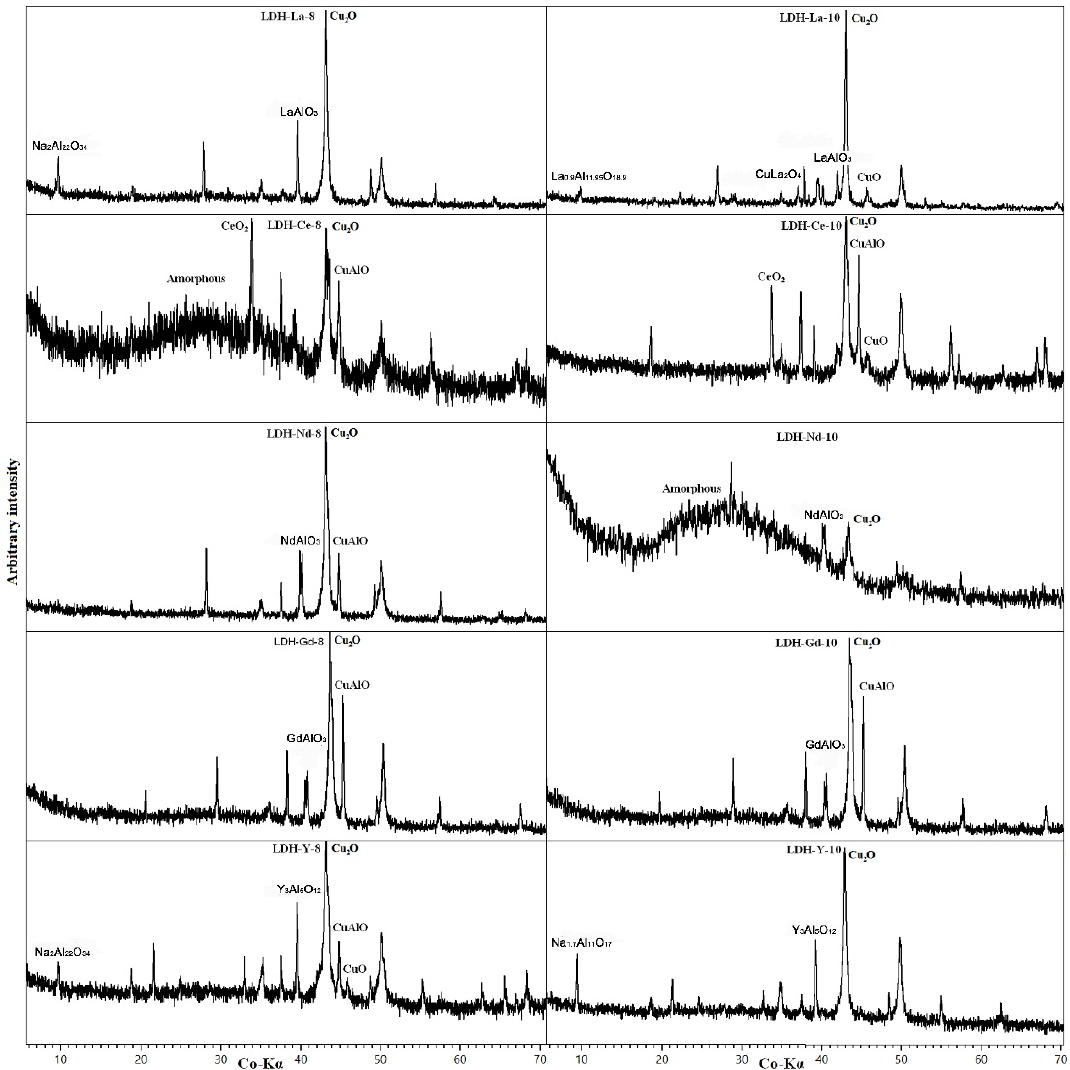
Figure 10. PXRD pattern of REE-doped samples after heating at 1400 °C. Only the main maximum for every phase is labelled. every phase is